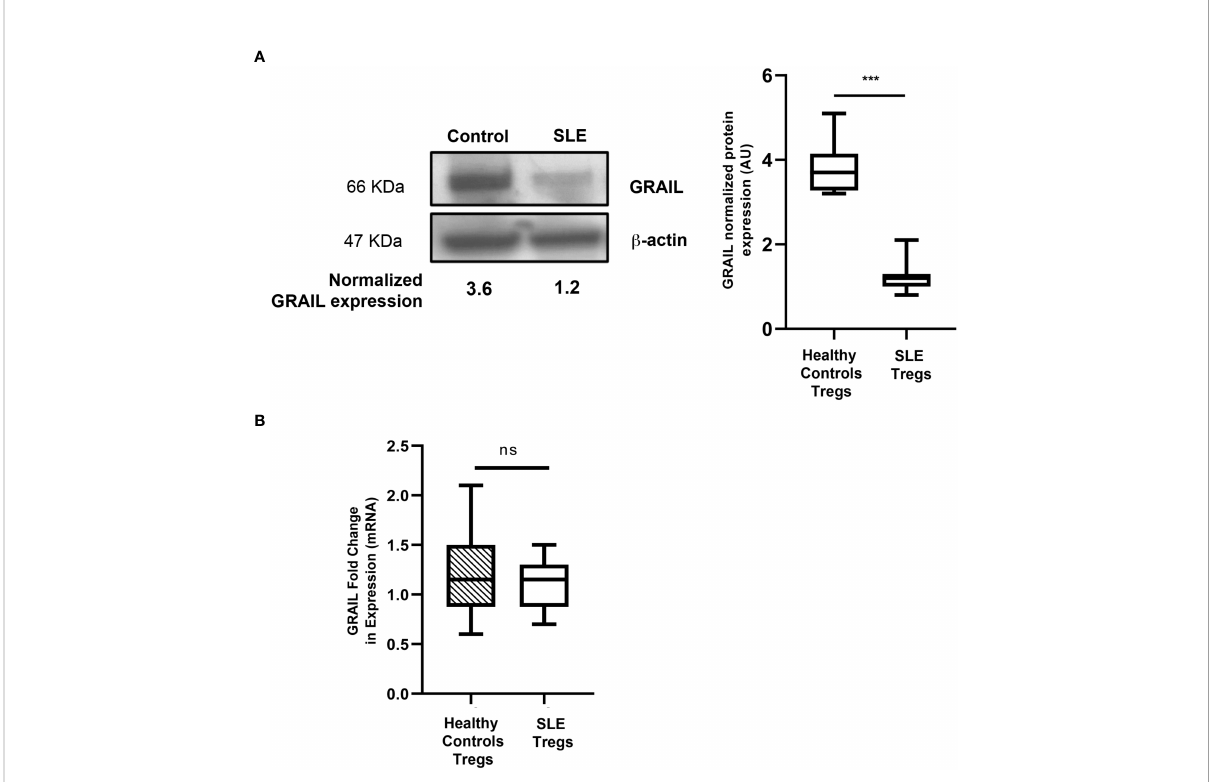
FIGURE 3 GRAIL expression in the Tregs of patients with SLE. (A) Immunoblotting data showing loss of GRAIL expression in the T regs of a representative SLE patient vs. healthy control; the graph shows the pooled data in which SLE T regs are de fi cient in GRAIL protein expression vs. healthy controls (HC=10, SLE=25 ***p < 0.0001 by unpaired T test). The T regs from SLE patients were found to be de fi cient in GRAIL expression and had diminished T reg function irrespective of disease activity (data not shown). (B) No differences were found in GRAIL mRNA levels in T regs from SLE patients compared to healthy controls (HC=10, SLE=10 p=0.4715 by unpaired T-test). ns, not signi fi cant.